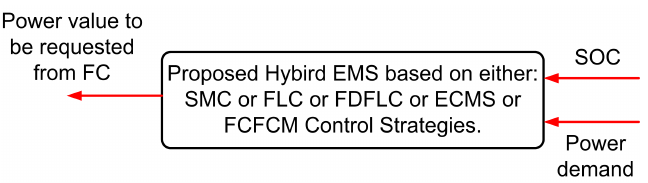
Figure 5. Representation of the implementation of the energy management strategy (SMC: State Ma- chine Strategy, FLC: Fuzzy Logic Control, FDFLC: Frequency Decoupling and FLC, ECMS: Equivalent Consumption Minimization Strategy, FCFCMS: FC Fuel Consumption Minimization Strategy).